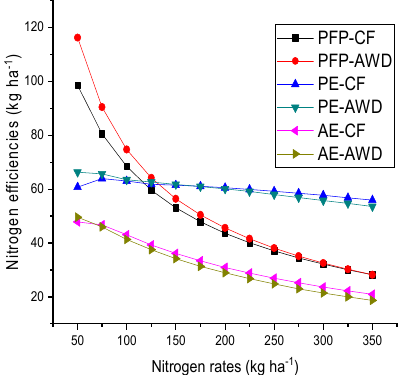
Figure 7. Simulated Nitrogen uptake and applied fertilizer N, with AWD and CF conditions. Each value is the average of 45 years between 1961 and 2005. The bars show the standard deviation among years for each N rate.